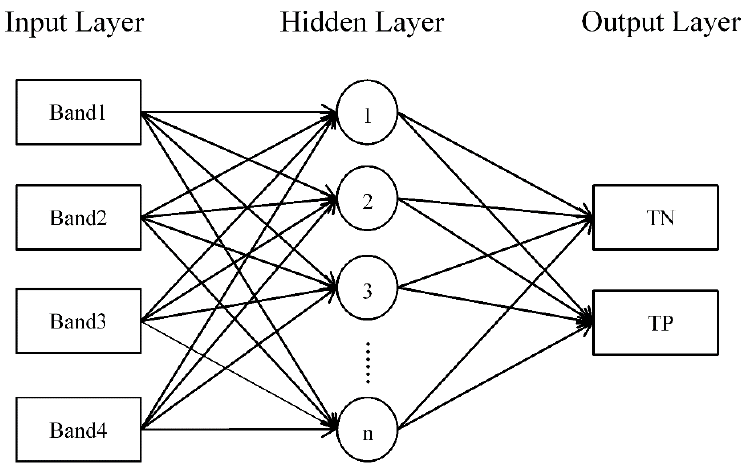
Figure 3. A neural network diagram for this study.